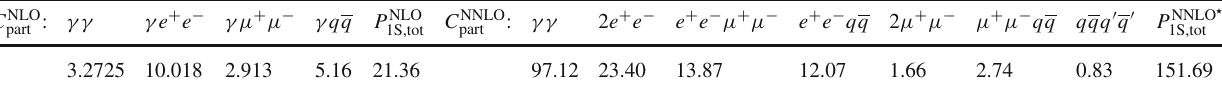
Table 2 Coefficients for the sum of all NLO and partial NNLO corrections of each partial para-ditauonium decay channel, C NLO,NNLO P NLO and P NNLO (cid:19) correction terms as defined in Eqs. (38) and (39) for its total annihilation decay width 1S,tot 1S,tot